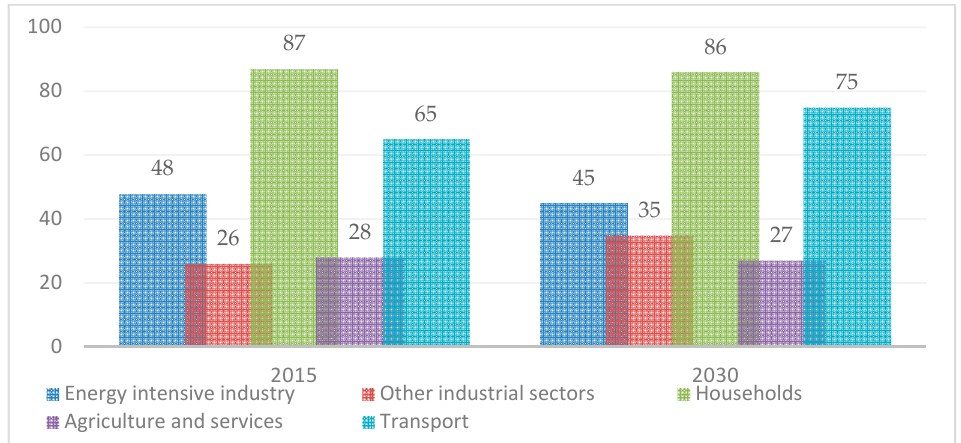
Figure 2. Final energy demand by sectors in 2015 and 2030, Source: Own research based on National Energy Regulatory Authority (ANRE) data [20].